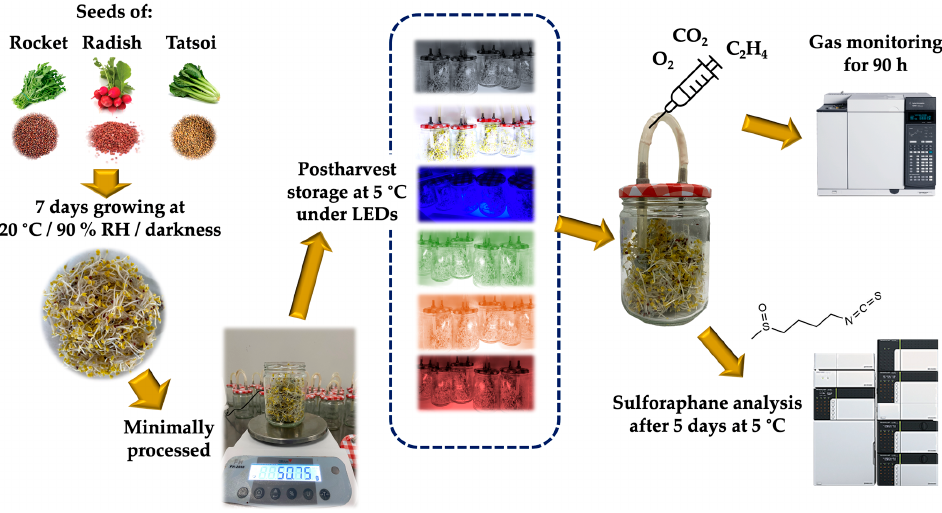
Figure 1. Experimental